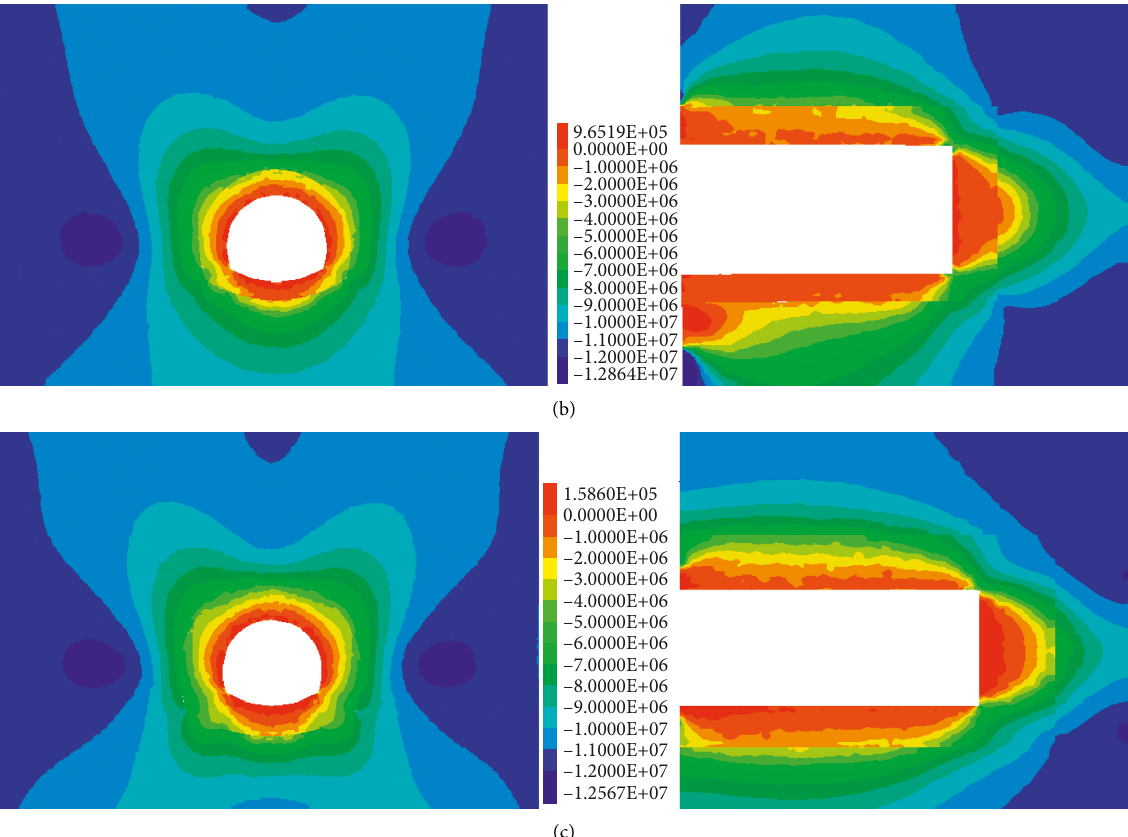
Figure 7: Distribution characteristics of minimum principal stress of surrounding rock. (a) Tunnel excavation without surrounding rock modification. (b) The modified depth 3 m. (c) The modified depth 5